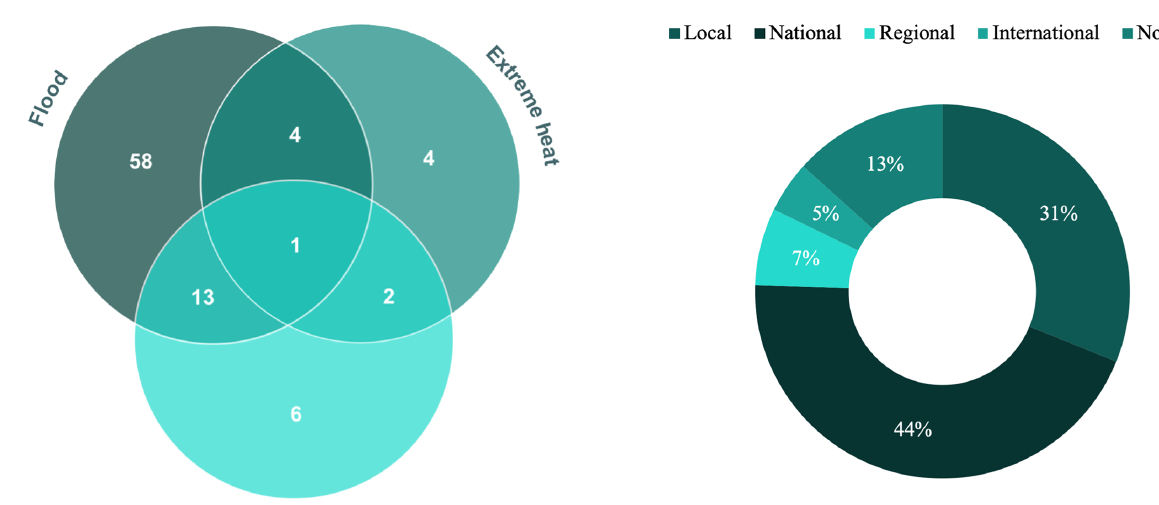
Figure 4. Implementation scale of NBSs. Local-scale NBSs are conceived as those implemented in specific local communities in a country, often by local actors, including non-profits (NGOs), community-based organisations (CBOs), local government admin- istrations or the community. National NBSs are implemented in dif- ferent locations within the same country and are often advanced or coordinated by national agencies. Regional NBSs refer to those that transcend two or more SSA countries. Lastly, international-scale NBSs are conceived as those implemented in SSA and countries on other